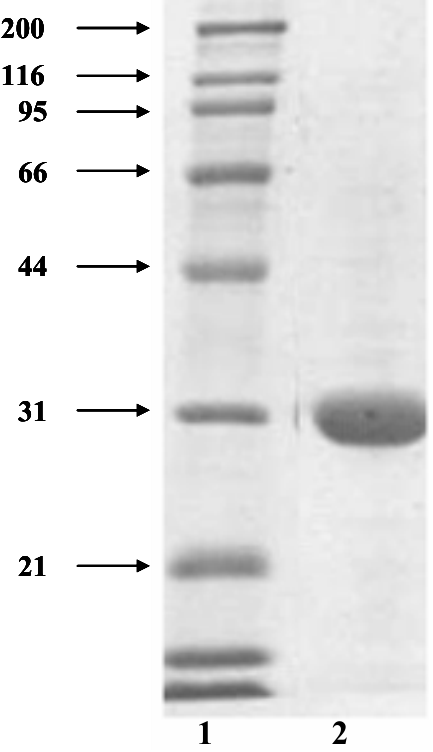
Figure 1. SDS-poliacrilamide electrophoresis pattern of the purified tepary bean ( Phaseolus acutifolius ) lectin. Lane 2, purified tepary bean lectin from fetuin affinity chromatography. Lane 1, molecular weight markers: myosin (200 kDa),  -galactosidase (116 kDa), phosphorylase (97 kDa), bovine serum albumin (66 kDa), carbonic anhydrase (31 kDa), trypsin inhibitor from glycine max (21 kDa).